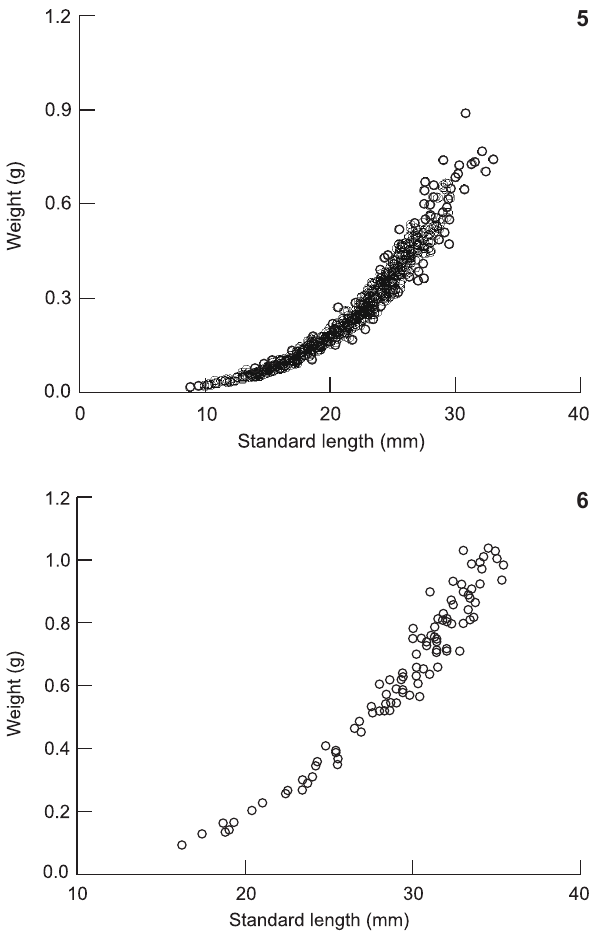
Figures 5-6. Weight/length relationship for H. marginatus in the Piravevê sub-basin (5) and Vitória sub-basin (6), Ivinhema River